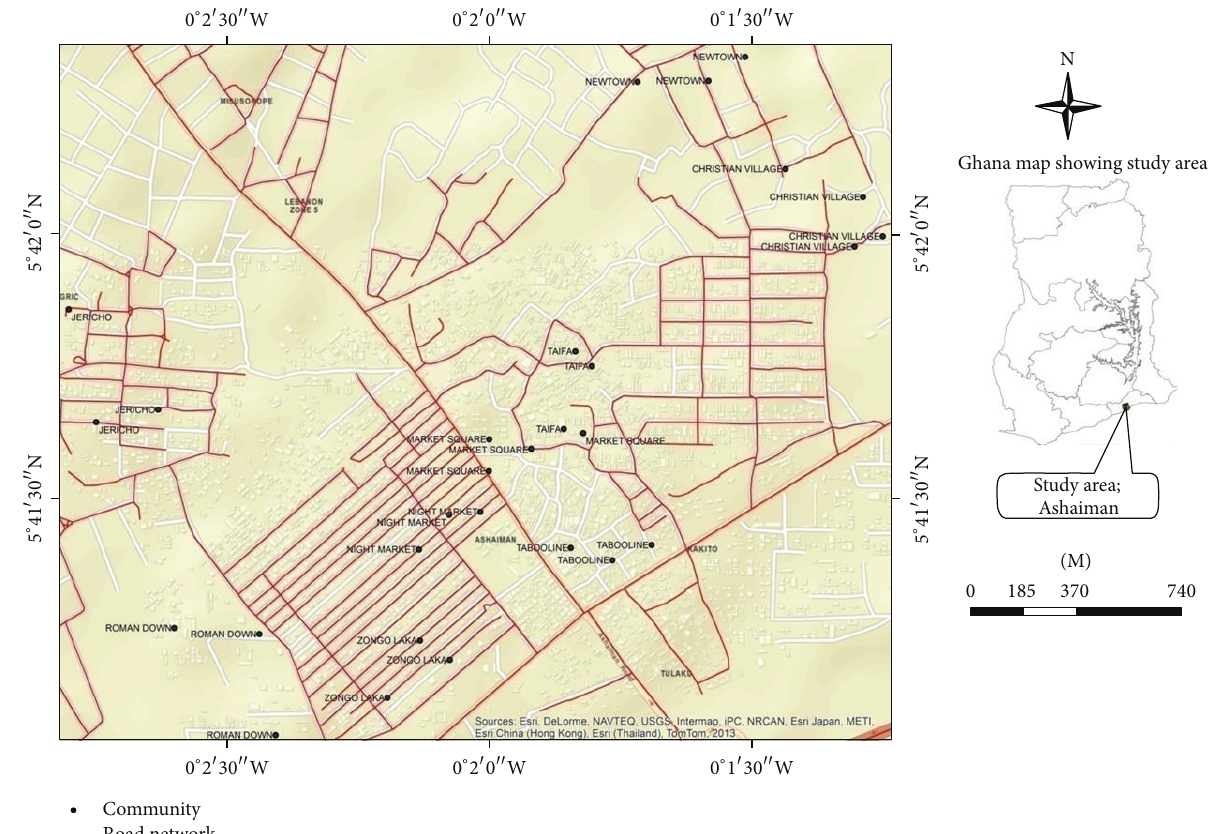
Figure 1: Map of Ashaiman showing the selected